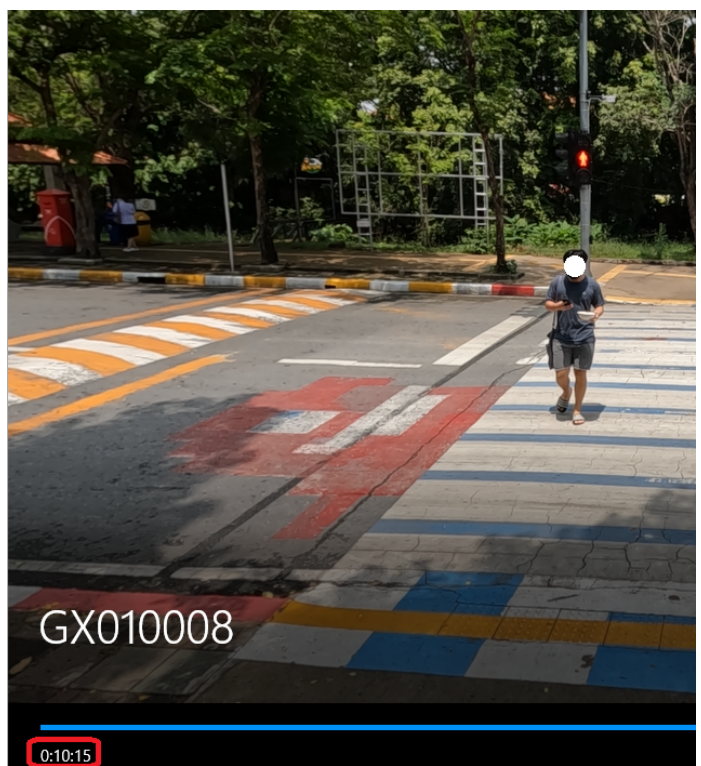
Figure 6. The video frame (cropped to fit) that the top 1 result in Figure 5 originates from. Note that the current time in the video of 0:10:15 matches with the value in Figure 5 and that it is the same